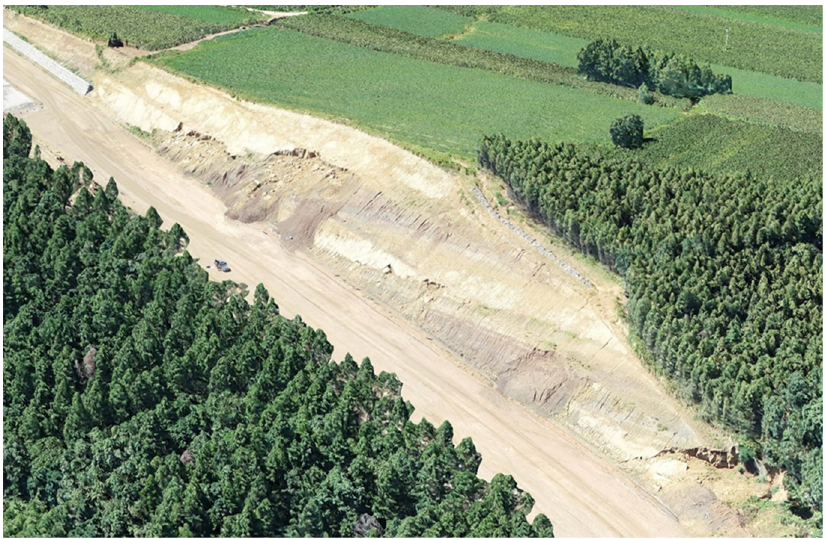
Figure 2. Landslide of the study area.